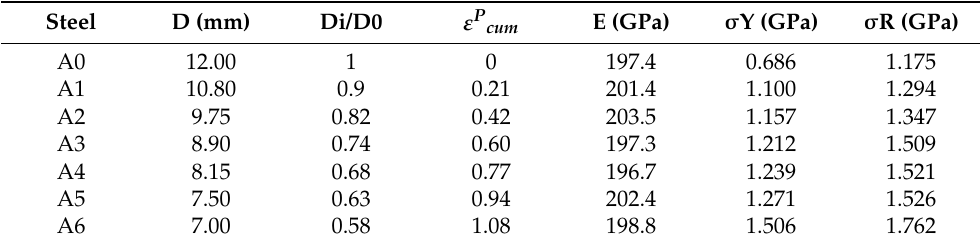
Table 2. Wire dimensions and mechanical properties of the steel